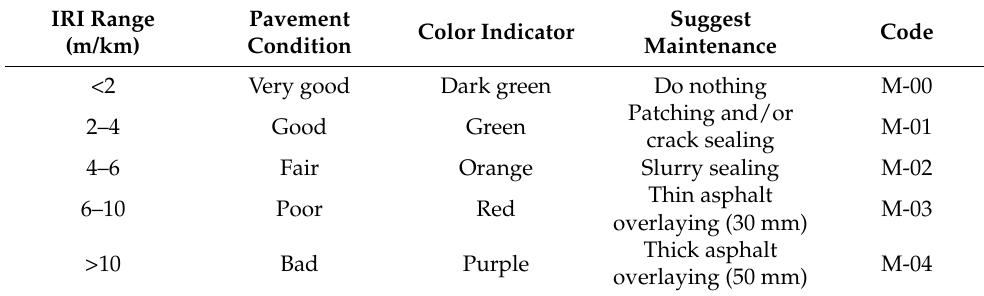
Table 2. Suggested pavement maintenance activity vs. IRI ranges.